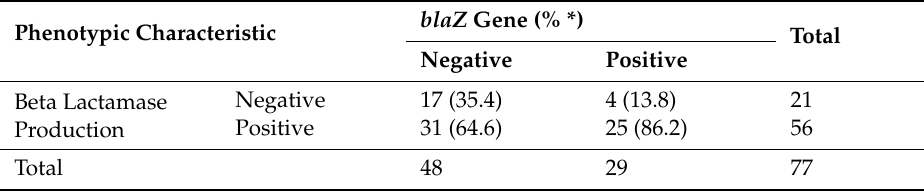
* Percentages calculated across columns.